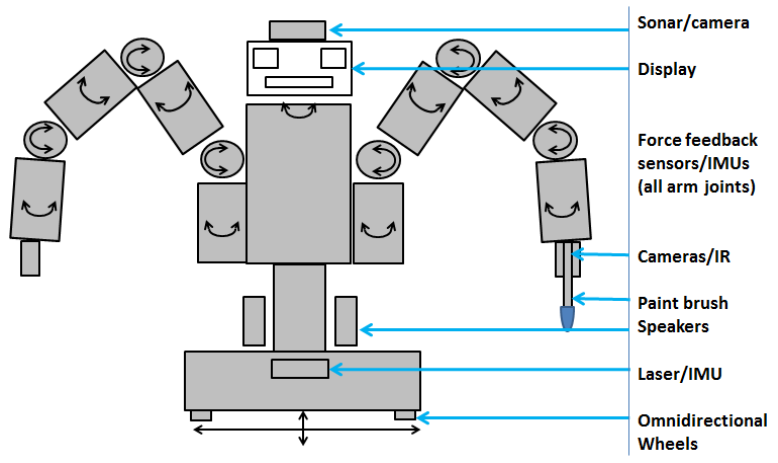
Figure 3. Baxter, showing sensors and